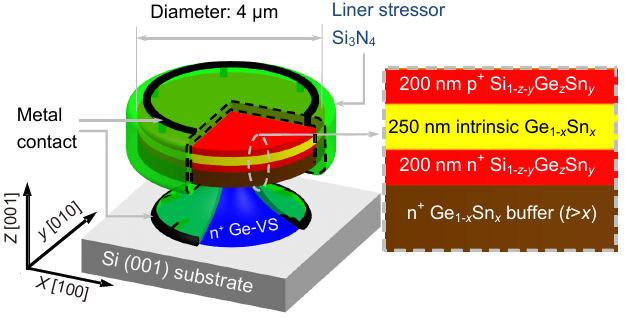
Fig. 10 | 3D schematic of lattice-matched GeSn/SiGeSn DH LED wrapped in a Si 3 N 4 liner stressor . Figure reproduced from ref. 37 , Optical Society of